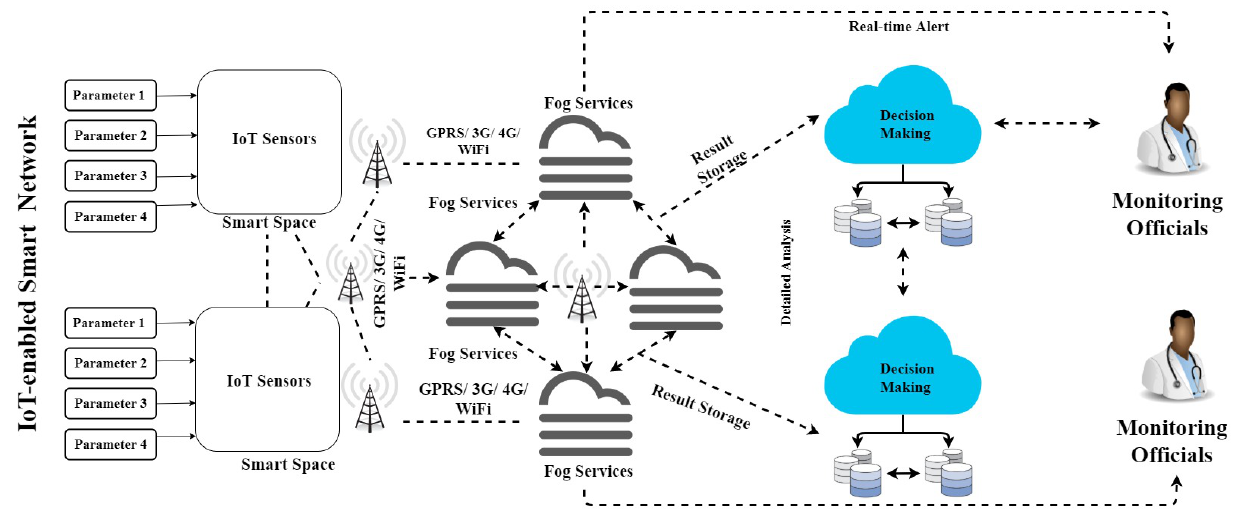
Figure 3. Conceptual framework of early prediction of